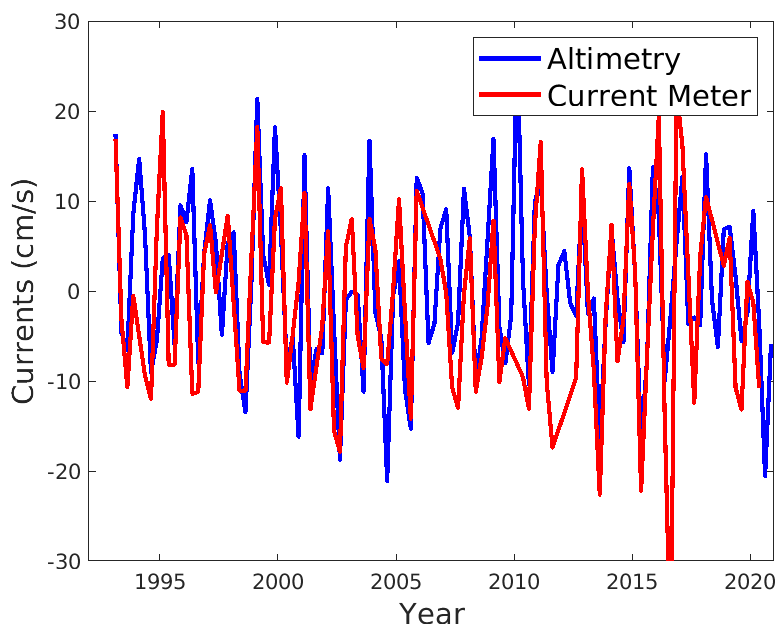
Figure 2. Seasonal-mean longshore currents (positive poleward) at the shelf break. The current data are at 35 m below surface at A1. The altimetry current is the geostrophic surface current over a 25 km segment on the South Vancouver Island transect.